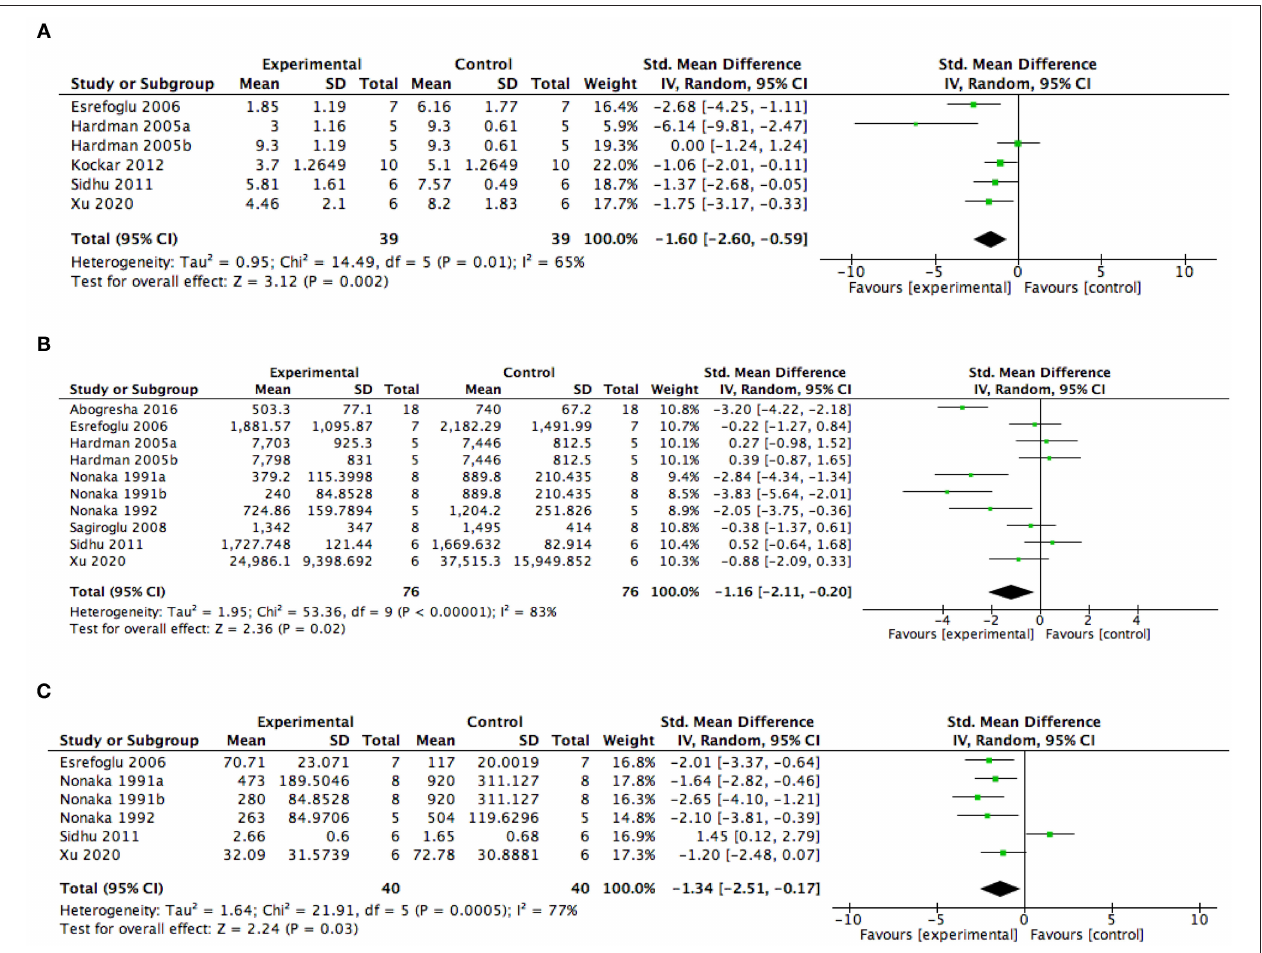
FIGURE 4 | Summary meta-analysis of studies reporting the effect of ascorbic acid administration on outcomes in animal models with AP compared with controls: (A) histopathological scores of pancreatic injury, (B) serum amylase levels, and (C) serum lipase levels. SD, standard deviation; Std., mean difference, standardized mean difference; IV, inverse variance; CI, confidence interval; Tau 2 , tau-square statistic; Chi 2 , chi-square statistic; df, degrees of freedom; I 2 , I-square heterogeneity statistic, Z, Z